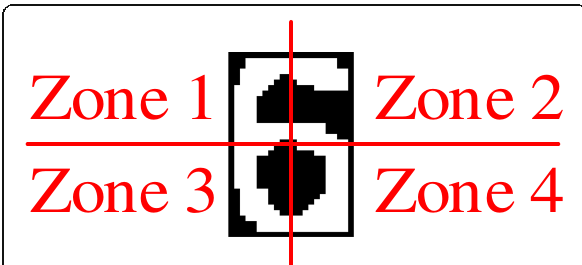
Fig. 6 The zones of each image